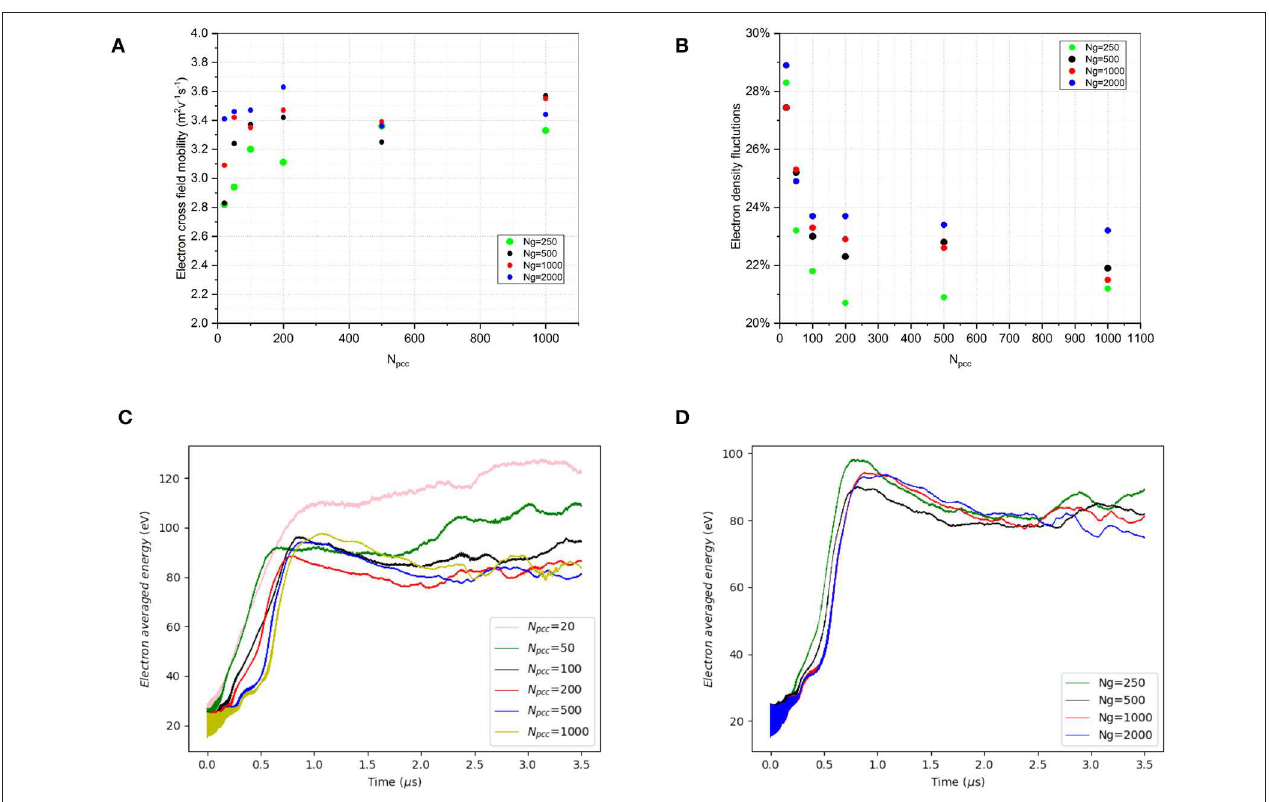
FIGURE 3 | (A) Computed mobility using Equation (8) and (B) amplitude of fluctuations in electron density as a function of the number of particles per cell N ppc for 1.44 (number of mesh nodes N g four different cell size 1 y λ De = for different N ppc using N g 1,000 (C) and for different N g using N ppc = azimuthal length of L y 2.67cm. =